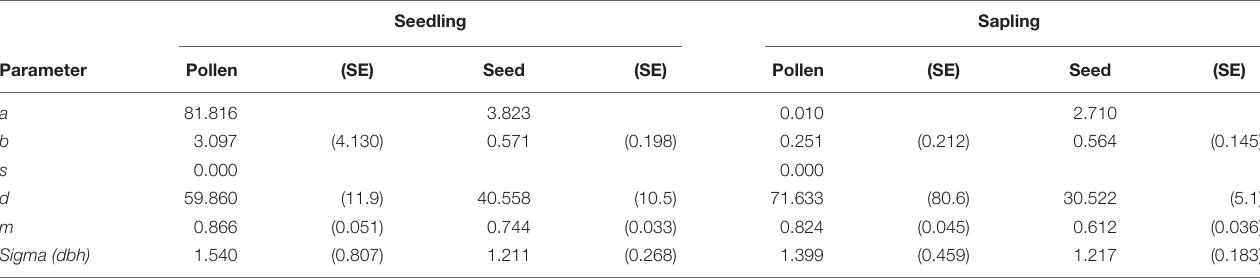
TABLE 4 | Parameters of pollen and seed dispersal kernels at the seedling and sapling stages, estimated according to the neighborhood model approach using exponential power